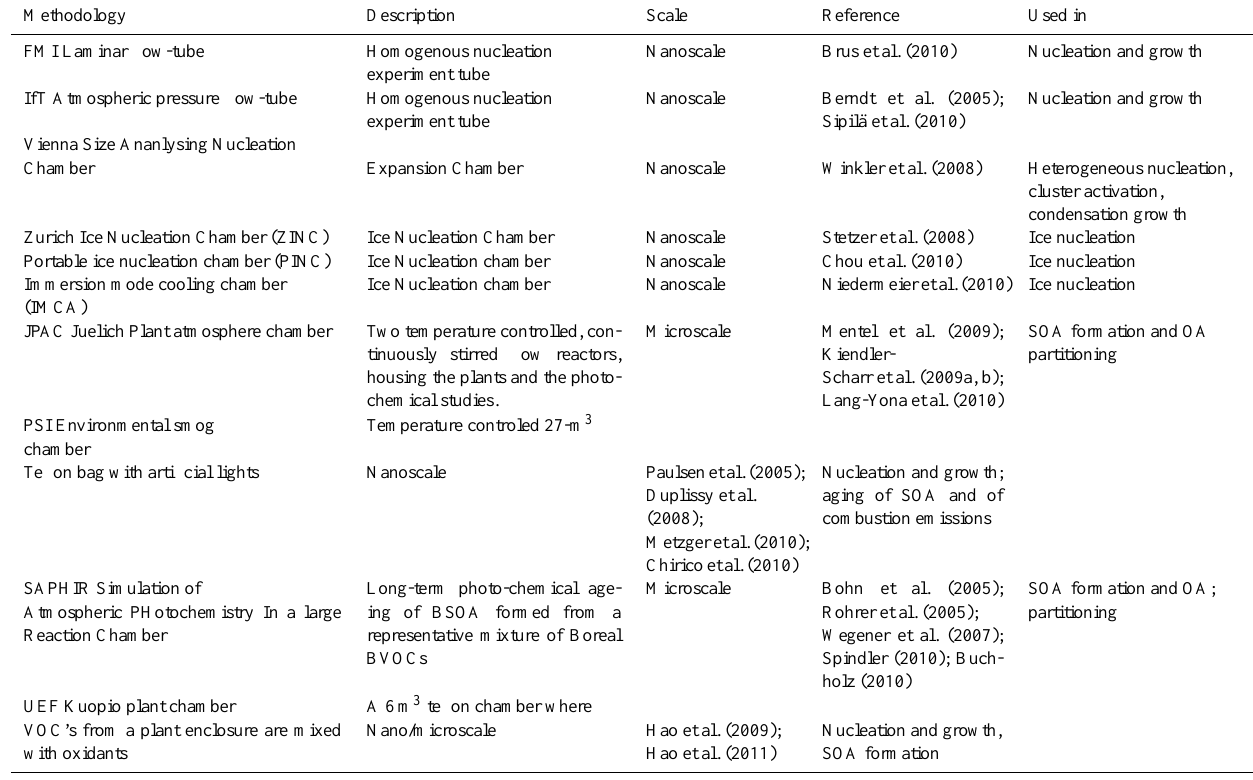
Table A1. Laboratory infrastructures used in EUCAARI.